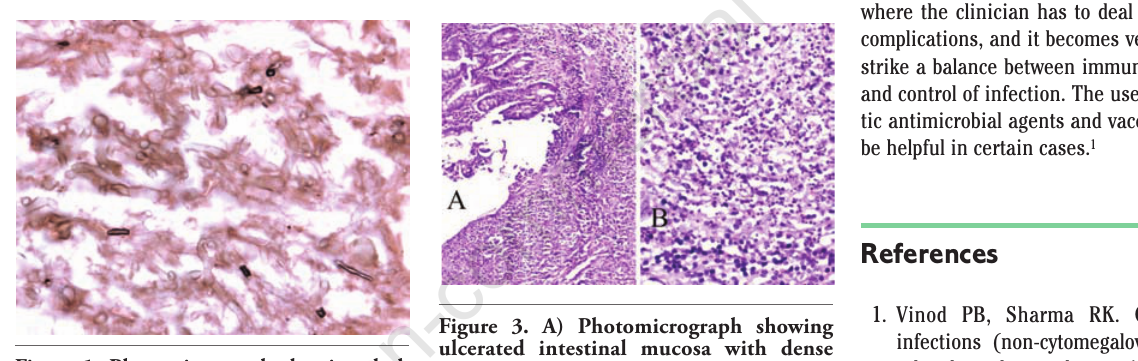
Figure 1. Photomicrograph showing dark brown, septate fungal hyphae with acute- angle branching (Haematoxylin and Eosin x 1000).